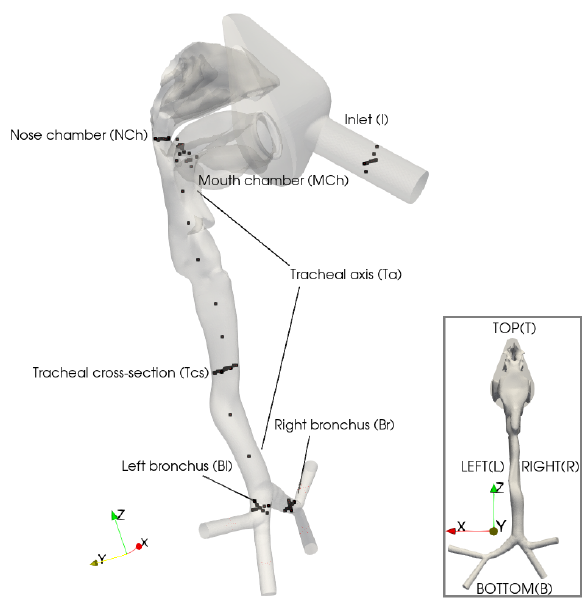
Fig. 3. Position of the investigated cross sections in the geometry matched by black spheres and direction